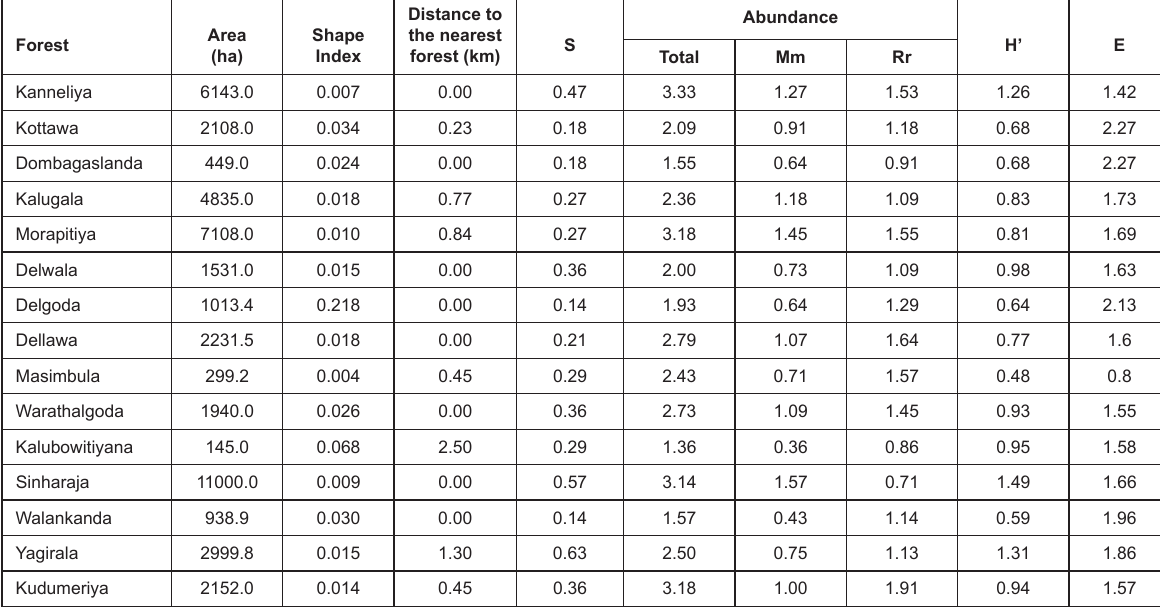
Table 1. Area, shape and distance to the nearest forest fragment of the selected forests and the species richness (S), abundance (number of species/individuals captured per 100 trap nights), abundance of the two predominant species Mus mayori (Mm) and Rattus rattus (Rr) and the diversity (H’) and evenness (E) values of the small mammal community of the fifteen rainforests. H’ and E values are from the Shannon-Wiener Diversity